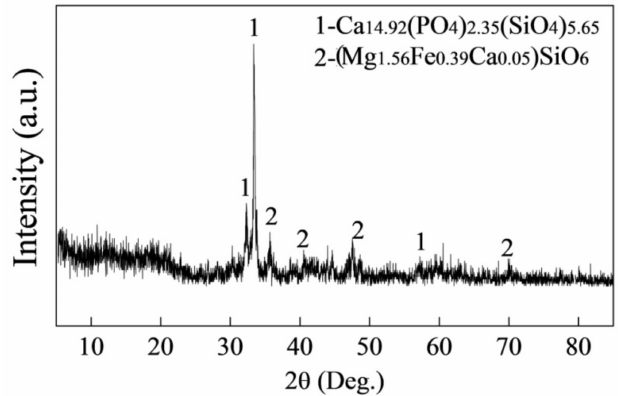
Figure 8. XRD pattern of dephosphorization slag in Heat 3.